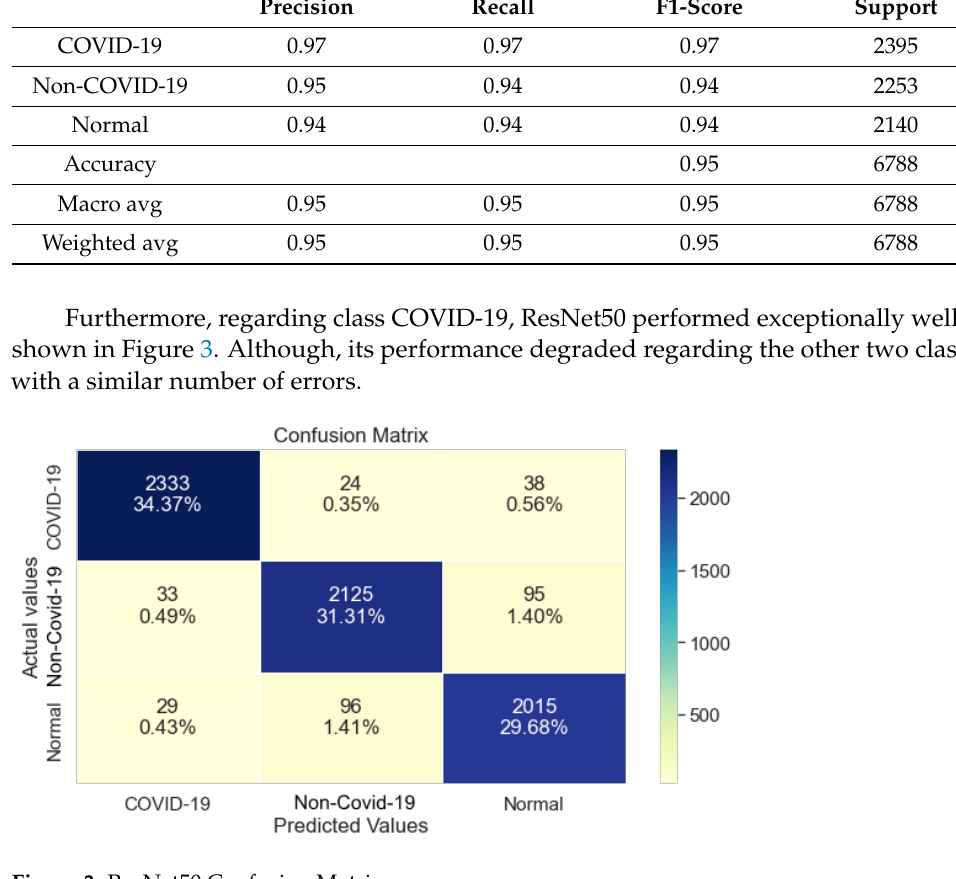
Table 3. ResNet50 Evaluation results.